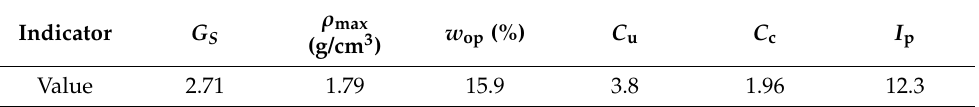
Table 1. Physical and mechanical parameters of soil samples.